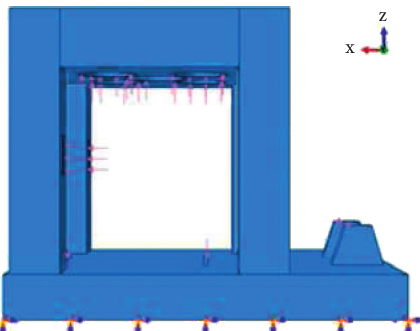
Figure 3: Simplified load and boundary constraints of the compression-shear test machine frame.